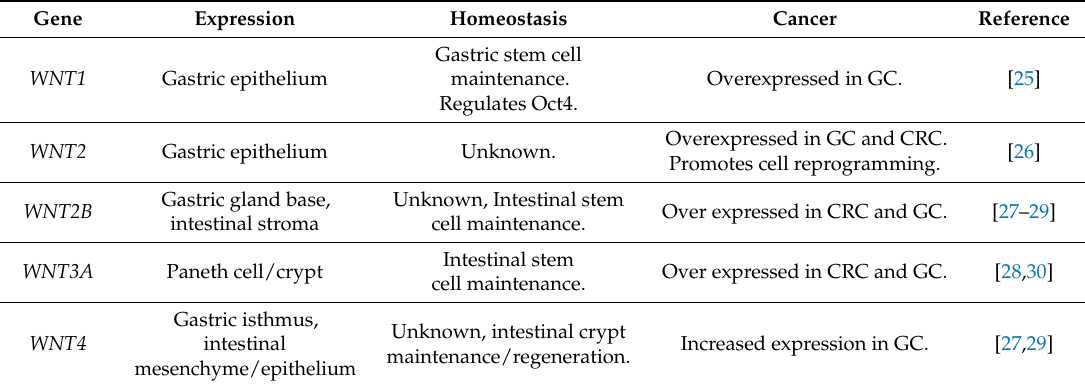
Table 1. The effects of Wnt ligands on gastrointestinal stem cell populations during homeostasis and